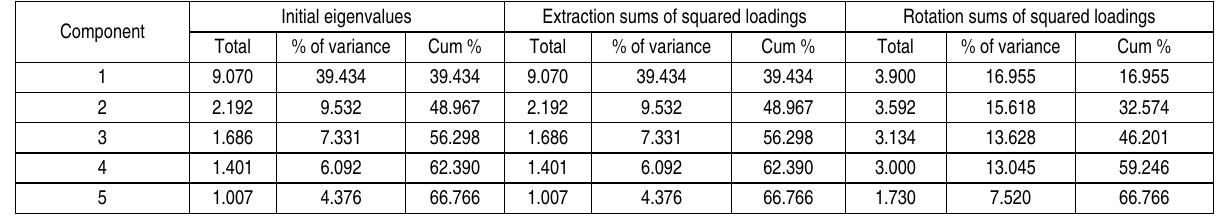
Table 1. Total variance physical work environment